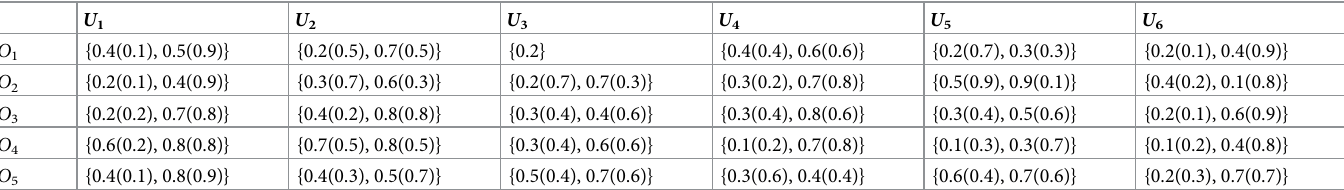
Table 3. PHF matrix R 3 given by the third expert.